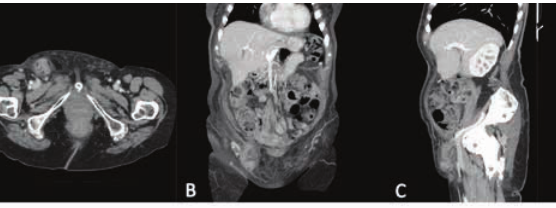
Figure 1: Case Report 1